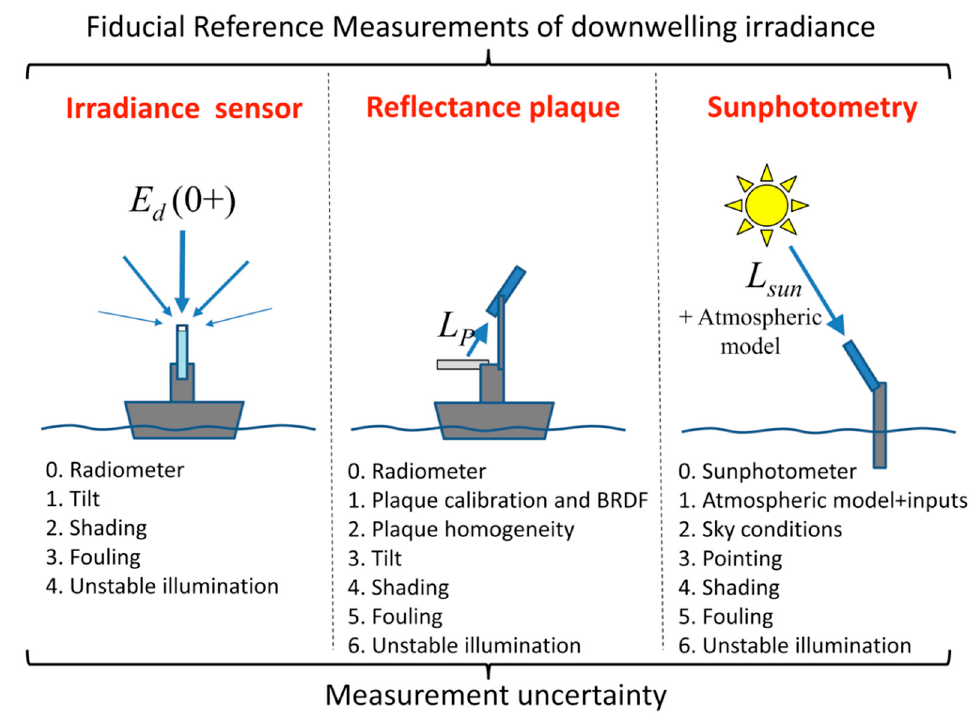
Figure 2. Summary of sources of uncertainty for the three generic families of method for measurement of downwelling irradiance. Reproduced with permission from [27].